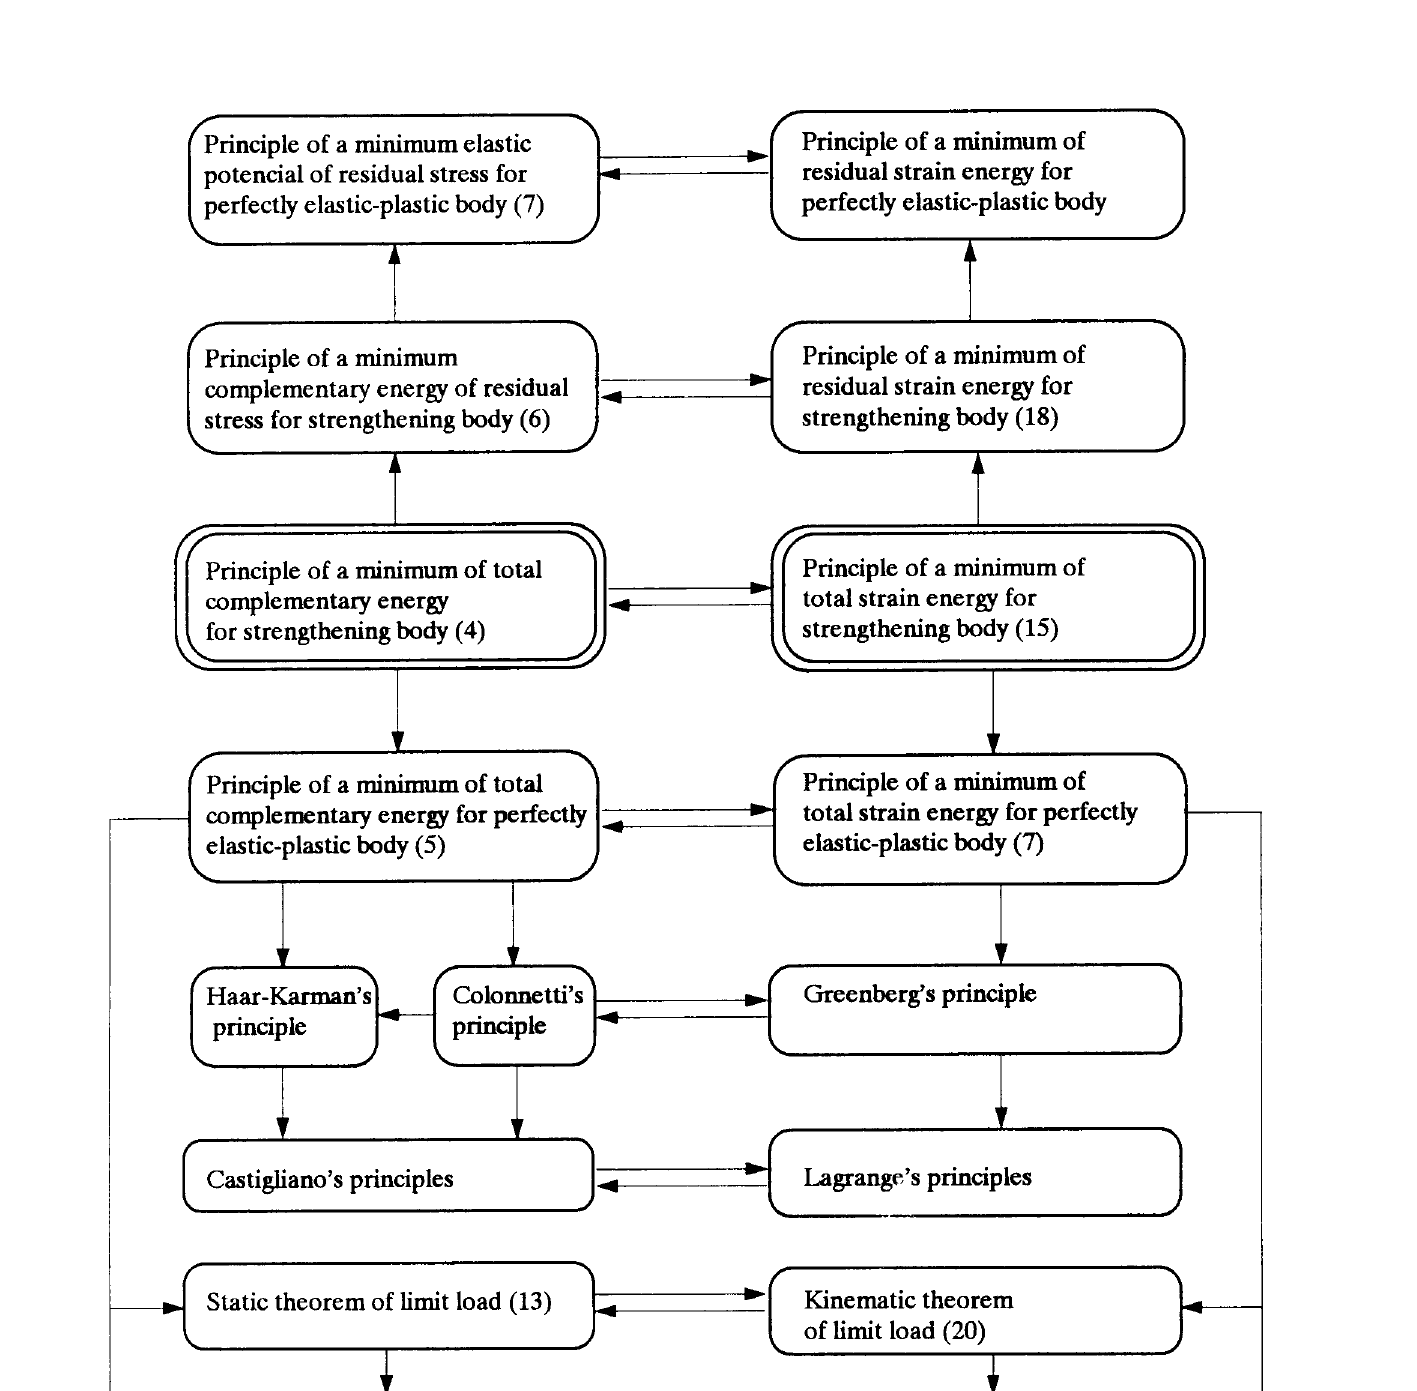
.. Kinematic theorem of plastic .